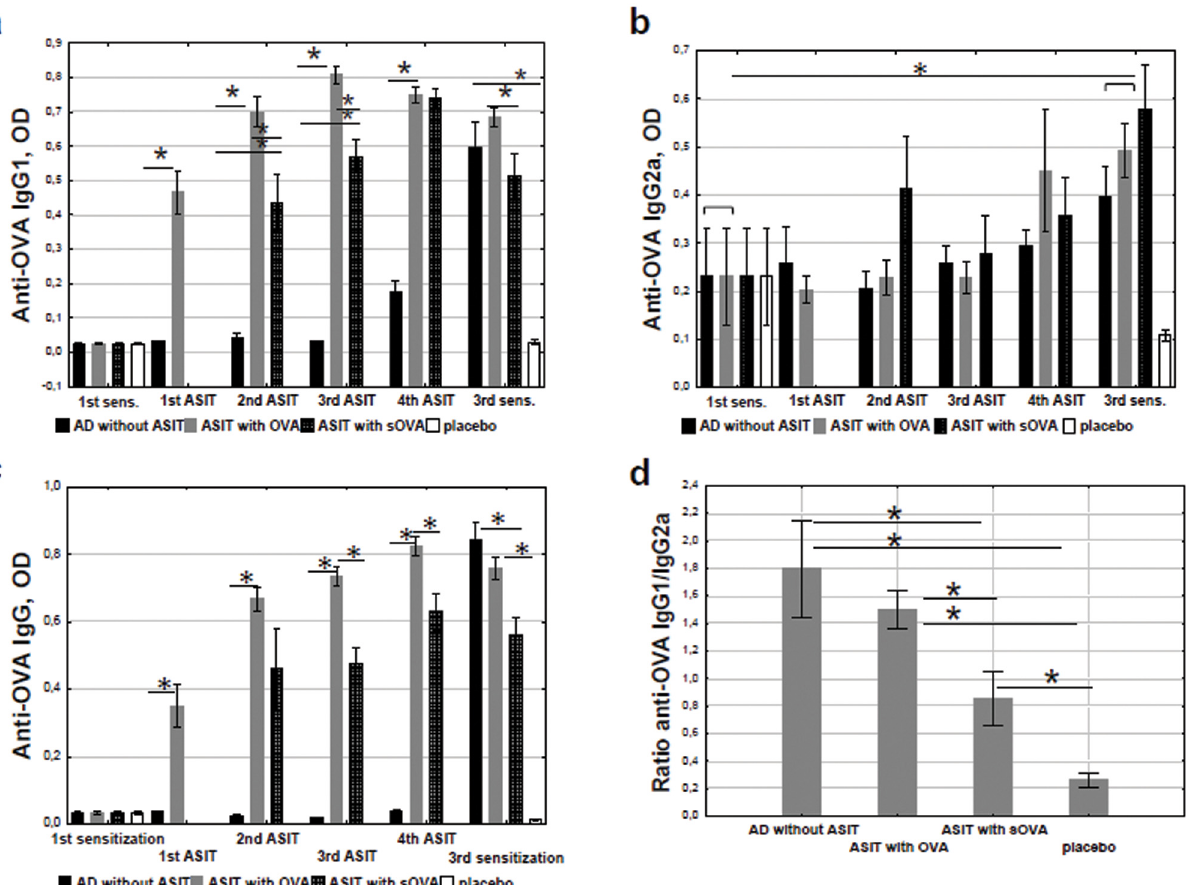
Fig 3. Analysis of OVA-specific IgG. The levels of antibodies in sera obtained before, during, and after ASIT were detected and quantified by ELISA. The results are presented as mean antibodies concentrations (mean ± SE, n = 8 for each). AD without ASIT: OVA-sensitized untreated mice; ASIT with OVA: OVA-sensitized mice treated by ASIT with OVA; ASIT with sOVA: OVA-sensitized mice treated by ASIT with sOVA; placebo: PBS-sensitized mice. (a) anti- OVA IgG1 response in mice with ASIT, (b) anti-OVA IgG2a response in mice with ASIT, (c) anti-OVA IgG response in mice with ASIT, (d) ratio of OVA- specific IgG1/IgG2a antibody in mice with ASIT, ( * , p < 0.05)